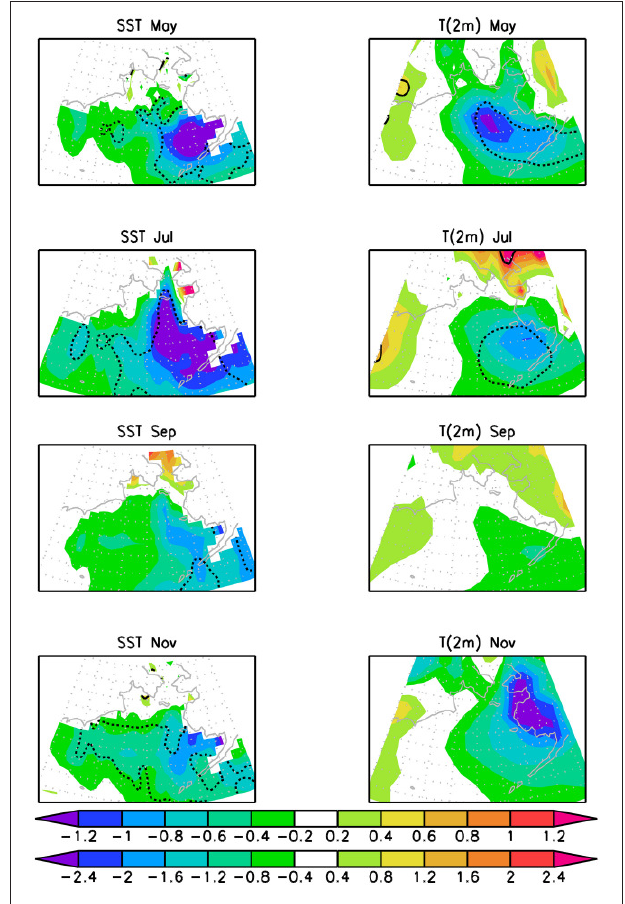
FIGURE 12 | Difference of SST ( ◦ C) (left) and surface (2 m) air temperature ( ◦ C) (right) in May, July, September, and November derived as mean during 2007–2013minus that during 2000–2006. The thick lines denote that the difference between 2007–2013 and 2000–2006 is significant at the 99% confidence level according to the Student t -test. The upper and lower color bar is for SST and surface air temperature,